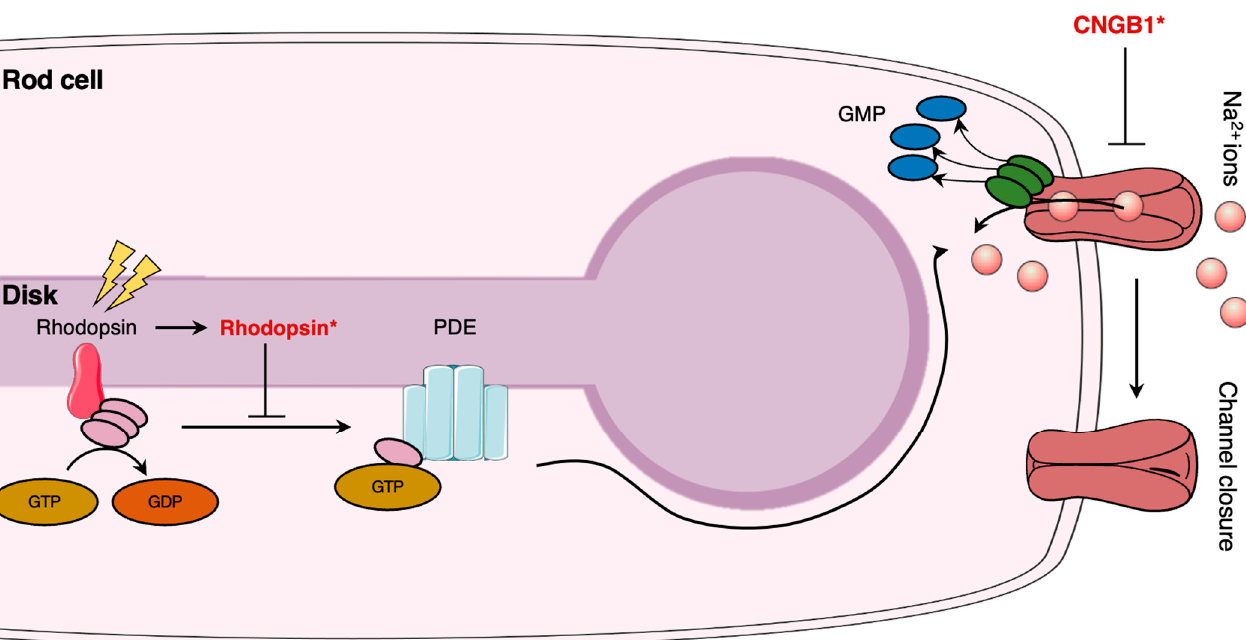
Figure 2. Schematic illustration of phototransduction mechanism and impacts of retinitis pigmentosa pathogenesis. In rod cells, light exposure induces transducer activation and subsequent phosphodiesterase (PDE) expression. PDE induces sodium channel closure. Rhodopsin (Rhodopsin*) and cyclic nucleotide-gate (CNG) ion channel mutations (CNGB*) alter rhodopsin signalization and are involved in retinitis pigmentosa pathogenesis. The figure was adapted from [98]. The Figure